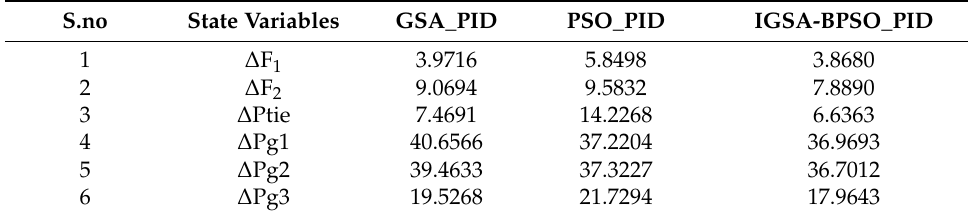
Table 2. Settling time values(s) for different optimization techniques (O.T.)–PBT.